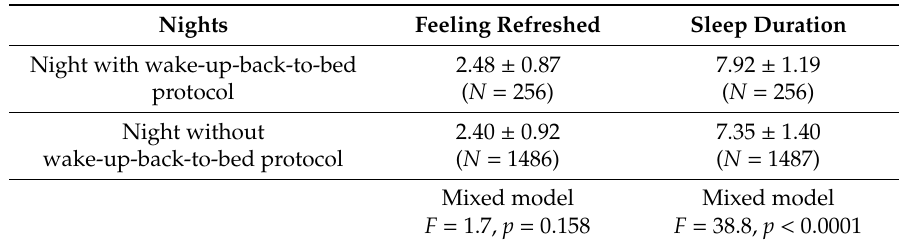
Table 3. Feeling of being refreshed and sleep duration after nights with wake-up-back-to-bed protocol compared with nights without wake-up-back-to-bed